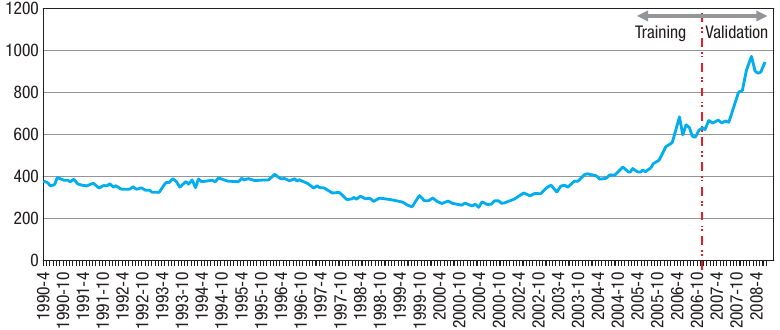
Fig. 4. Gold price changes (data resource: